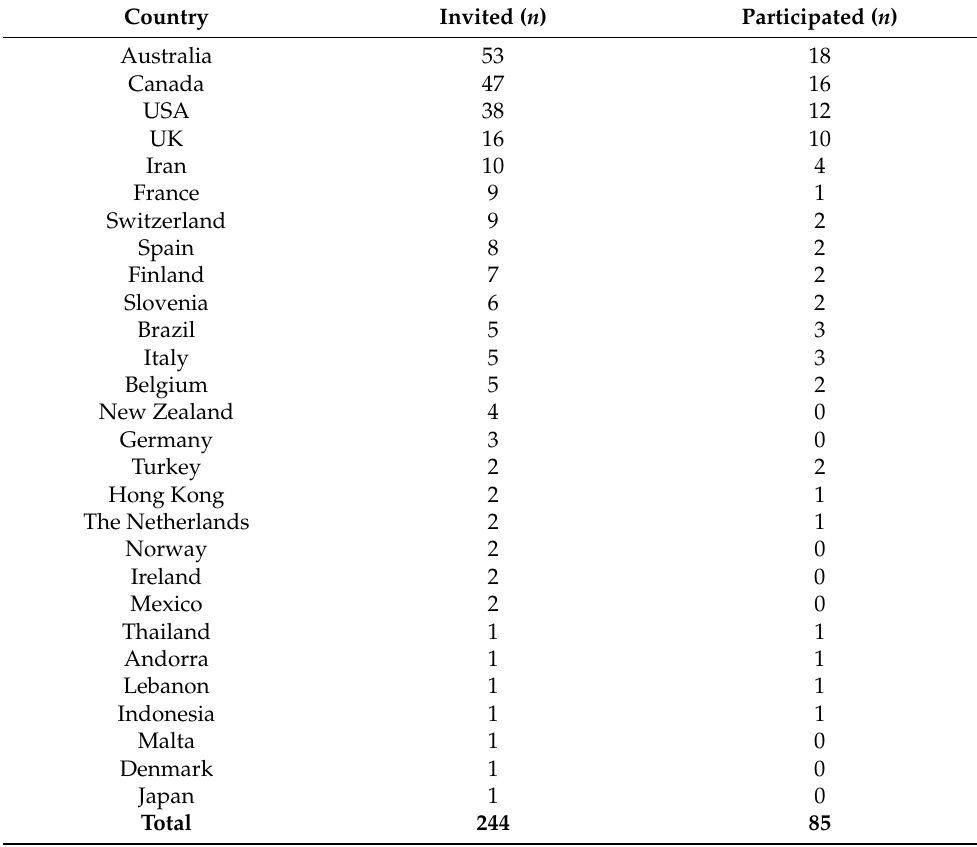
Table 1. Invited and participated experts for round two by country